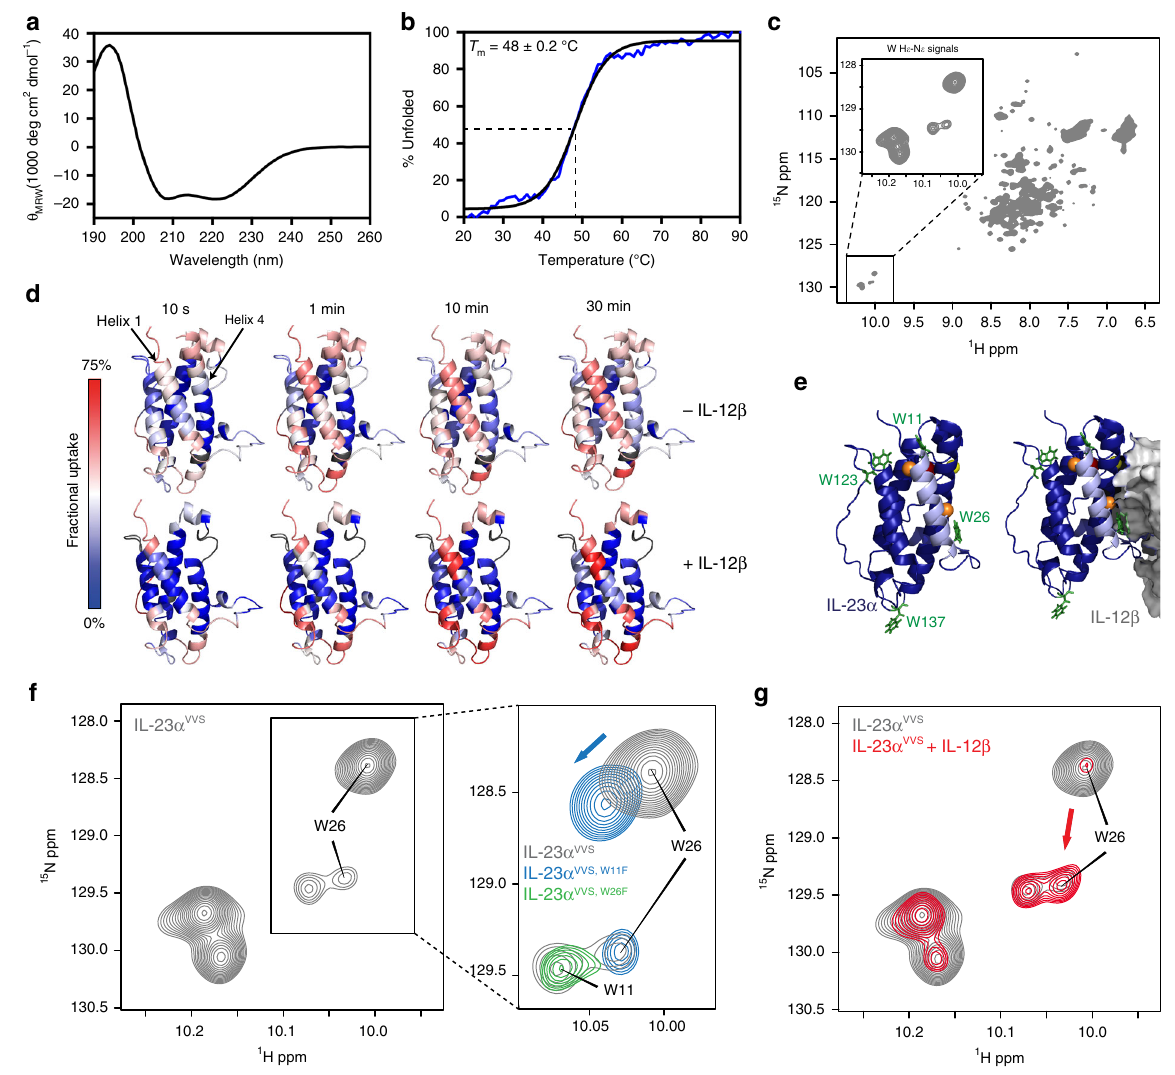
Fig. 3 Helix 1 in IL-23 α gains structure upon assembly with IL-12 β . a Far-UV CD spectrum of IL-23 α VVS . b IL-23 α VVS unfolds cooperatively with a melting temperature of 48 ± 0.2 °C. c 1 H, 15 N HSQC NMR spectrum of IL-23 α VVS ; the inset shows the down fi eld-shifted tryptophan indole side chain signals as zoomed view. d Hydrogen/deuterium exchange (HDX) experiments reveal helix 1 in IL-23 α VVS to be highly fl exible and to be stabilized upon interaction with IL-12 β . IL-23 α is colored according to the measured HDX rates. Blue colors correspond to a lower (less fl exible regions) and red colors to a higher ( fl exible regions) fractional uptake (gray: no sequence coverage in HDX measurements). e Structure of IL-23 α (blue) with helix 1 in light blue and cysteine residues shown, using the same color code as in Fig. 1d and in complex with IL-12 β (gray). Trp residues are shown in green. f Trp indole side chain signals in 1 H, 15 N HSQC experiments for IL-23 α VVS . Unambiguous assignment of W26 from the two minor signals was obtained by analyzing the spectra of IL- 23 α VVS, W26F (green, zoomed view) and an additional IL-23 α VVS,W11F mutant (blue, zoomed view). The intensity of the spectrum for IL-23 α VVS, W26F was lower and thus increased two-fold to allow for a comparison. g Same as f but for unpaired IL-23 α VVS (black) versus IL-23 α VVS in the presence of a two-fold molar excess of unlabeled IL-12ß (red). The intensity of the spectrum for IL-23 α bound to IL-12 β was increased to compensate the gain in molecular weight of the complex. The same experimental parameters were used for both